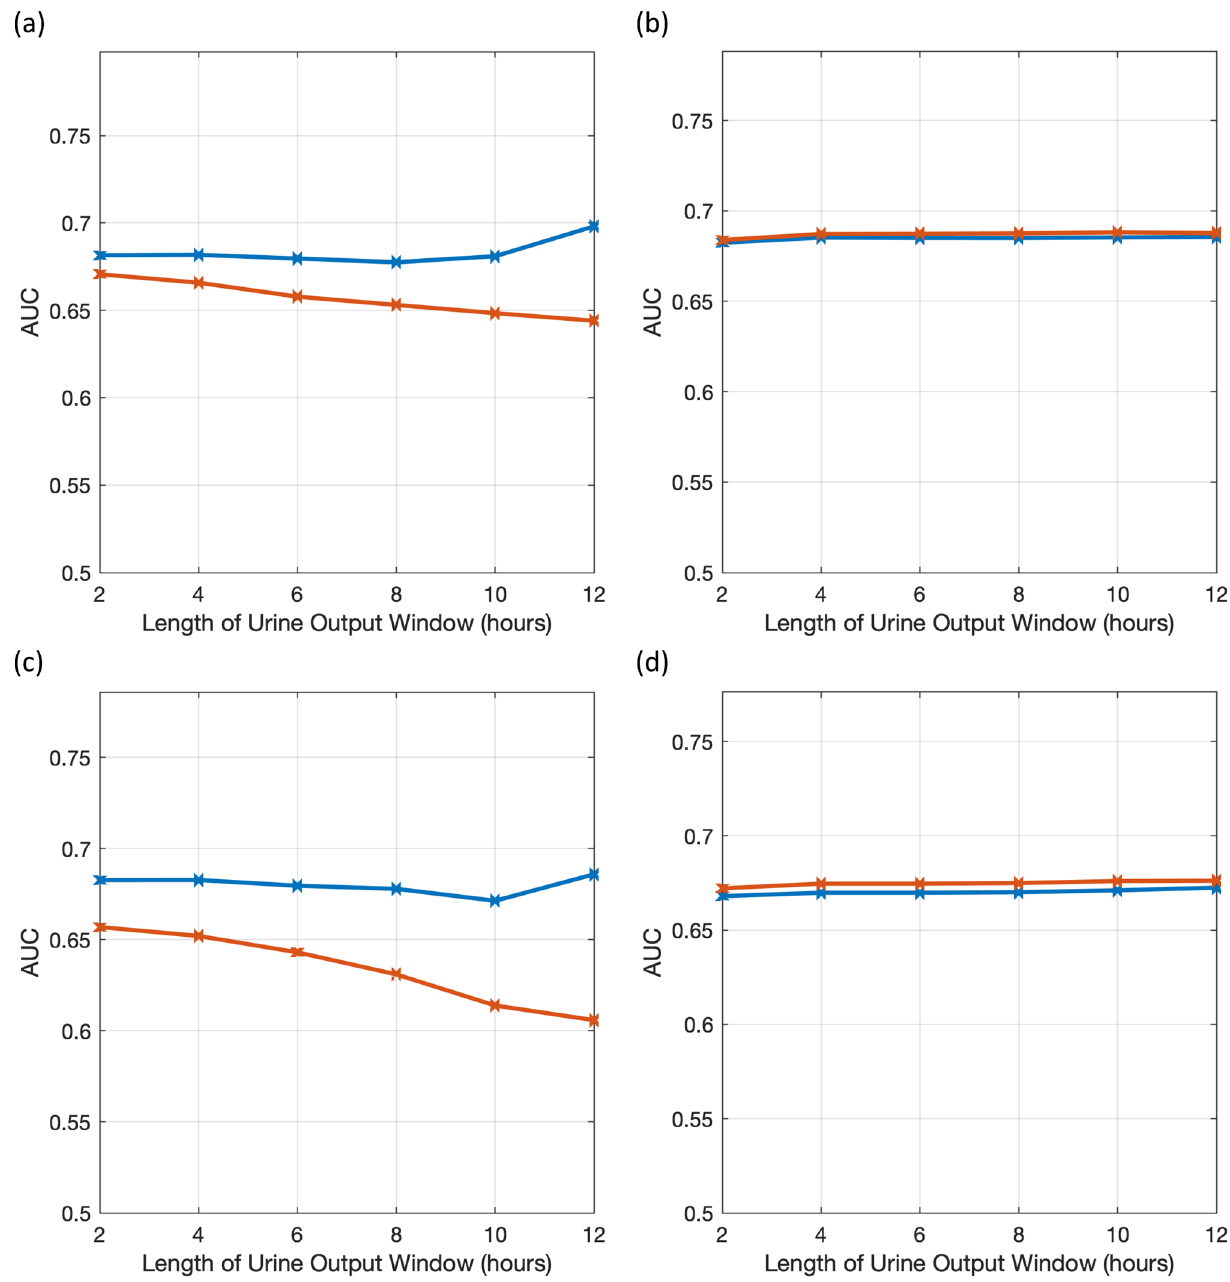
using MIMIC-III, (d) GLME model using eICU. Performance of multivariable generalized estimating equation models is plotted against duration of urine output data input to the model. The two curves represent results of training two distinct models on mutually exclusive partitions of the data and using the estimated models on a common test set that does not overlap with the training set. This has been done to confirm consistency of